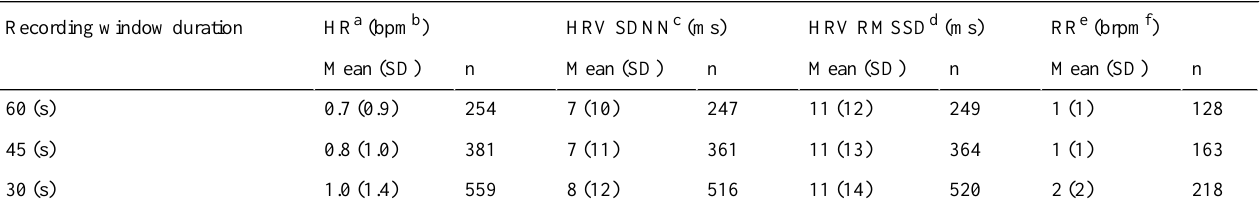
Table 5. Mean absolute error and SD of biometrics estimations from reference measurements at different recording window